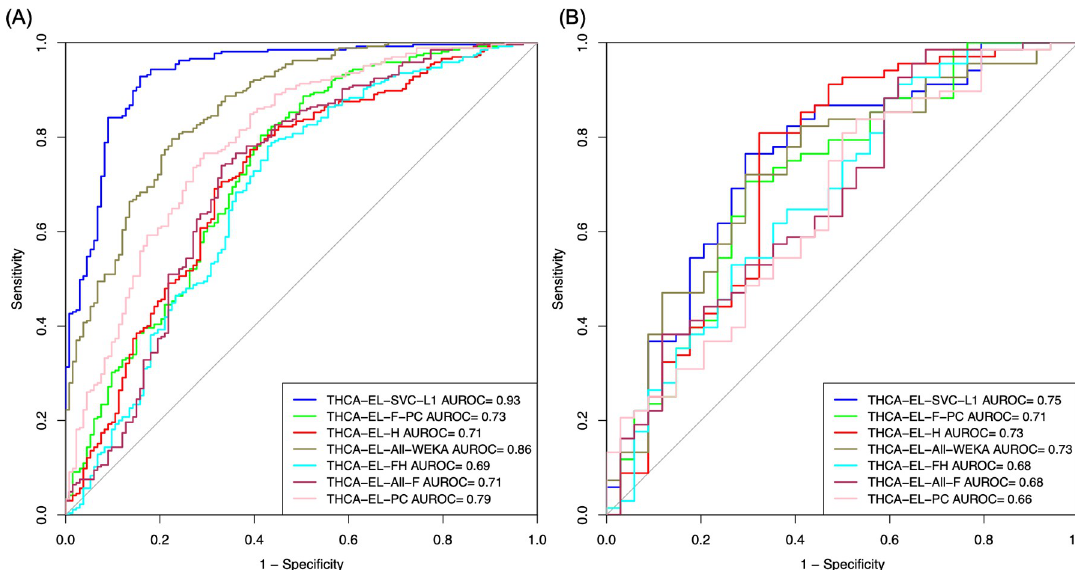
Fig 2. The AUROC plot comparing the performance of prediction models based on different feature sets for segregating early and late- stage tissue samples of (A) Training dataset and (B) Validation dataset.